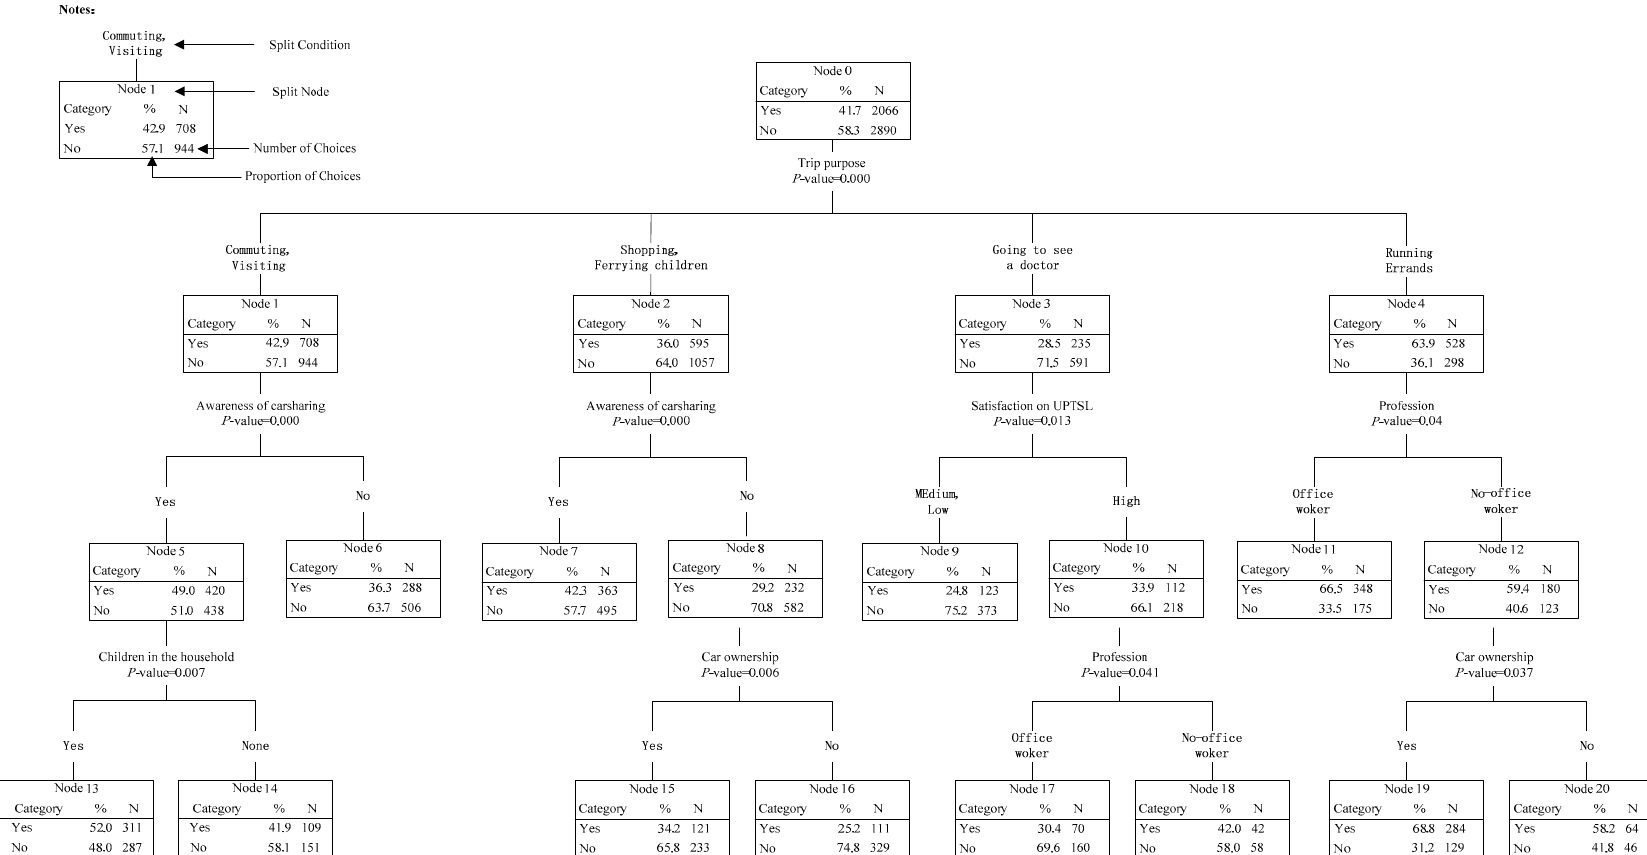
Figure 4. Hierarchical Tree-based Regression (HTBR) Model #1: Predicting predicting participants’ carsharing mode choice under different purposes.